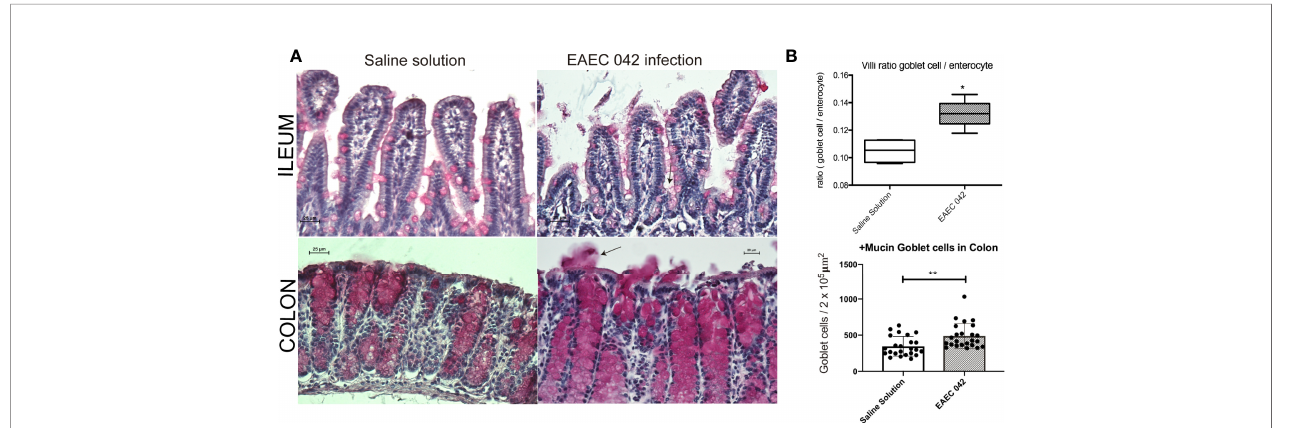
FIGURE 3 | Mucus secretion by mice infected with EAEC 042. (A) Ileum and colon stained with periodic acid-Schiff (PAS). Mucus mucopolysaccharide was stained in pink inside and outside the goblet cells. Increased secretion of mucus was observed in colon of infected mice with EAEC 042. Arrow indicates the mucus secreted to the lumen by the goblet cells. (B) Ileum villus and crypt ratios between goblet cell/enterocyte and colon goblet cell/area. Goblet and enterocyte cells were counted along the ileum (villi and crypts). Colon goblet cells were counted from 2 × 10 5 µm 2 of tissue area. The values represent the mean ± SD, N = 4 saline solution (control mice), 5 EAEC 042-infected mice, * p < 0.05, ** p ≤ 0.01. EAEC, enteroaggregative Escherichia coli .